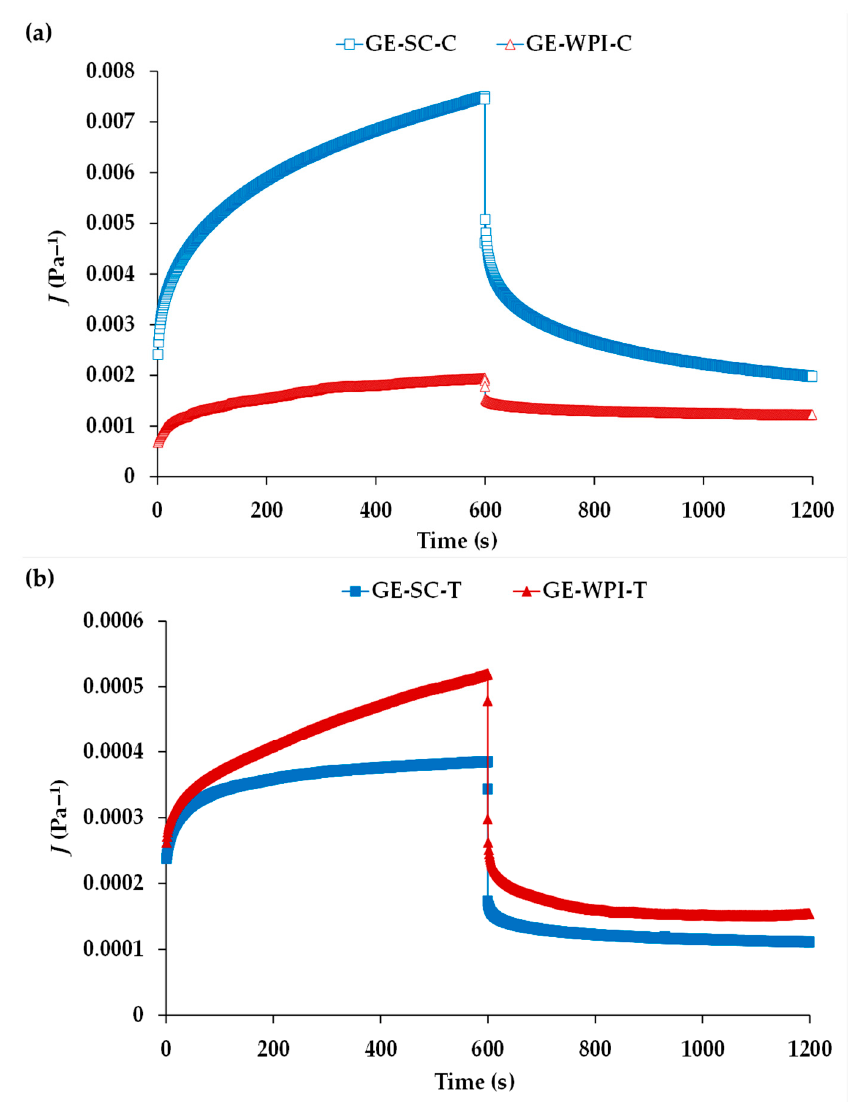
Figure 4. Evolution of creep and recovery compliance J ( t ) values for gelled emulsions (GEs): ( a ) stabilized by SC and WPI without added condensed tannins (GE-SC-C and E-WPI-C); ( b ) stabilized by SC and WPI with added condensed tannins (GE-SC-T and GE-WPI-T).